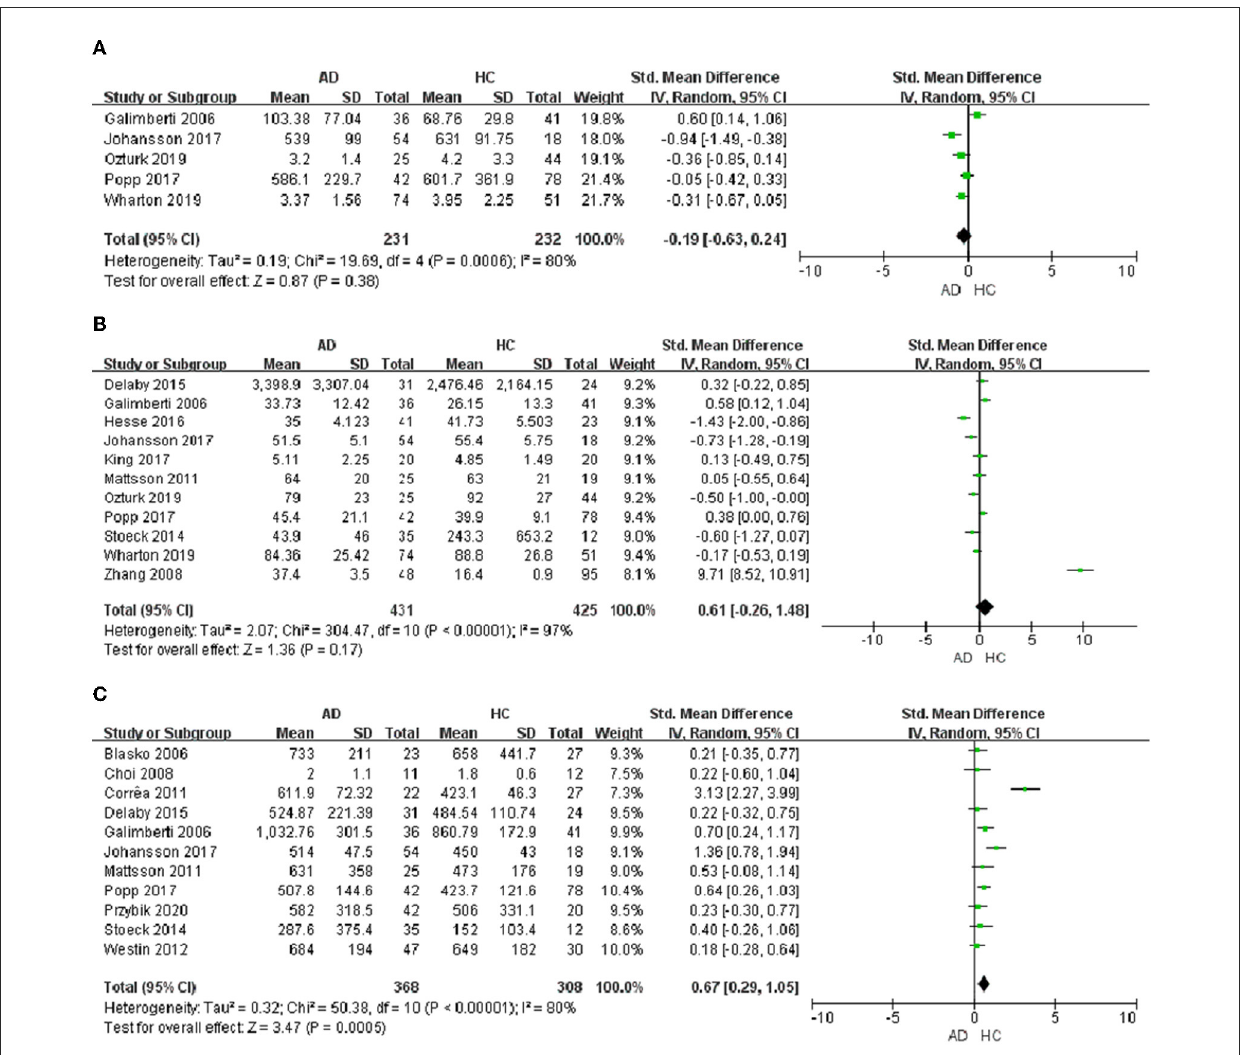
FIGURE3 Chemokine levels in the CSF of AD patients. (A) IP-10 protein content, (B) IL-8 protein content, and (C) MCP-1 protein